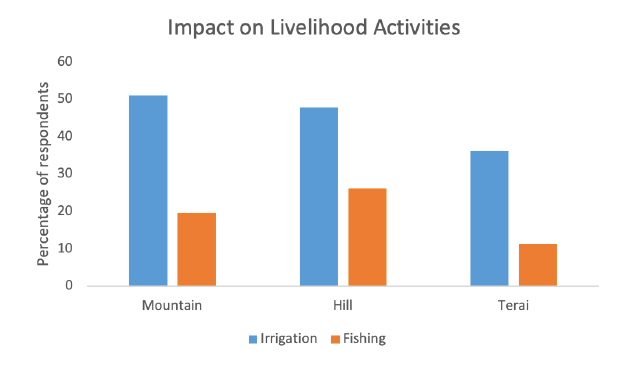
Fig. 6. Percentage of households whose irrigation and fishing activites were affected by river changes in each of three regions across the Karnali basin. N =